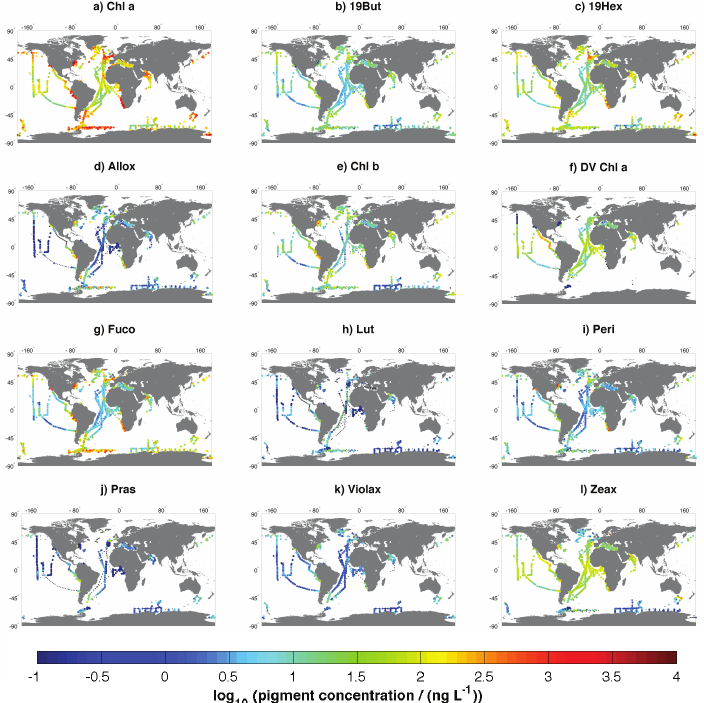
Figure 8. Pigment concentrations (ngL − 1 ) from MAREDAT averaged over the upper 20m: (a) chlorophyll a (Chl a ), (b) 19’- butanoyloxyfucoxanthin (19But), (c) 19’-hexanoyloxyfucoxanthin (19Hex), (d) alloxanthin (Allox), (e) chlorophyll b (Chl b ), (f) divinyl chlorophyll a (DV Chl a ), (g) fucoxanthin (Fuco), (h) lutein (Lut), (i) peridinin (Peri), (j) prasinoxanthin (Pras), (k) violaxanthin (Violax) and (l) zeaxanthin (Zeax). Data from all years were used in the averaging.